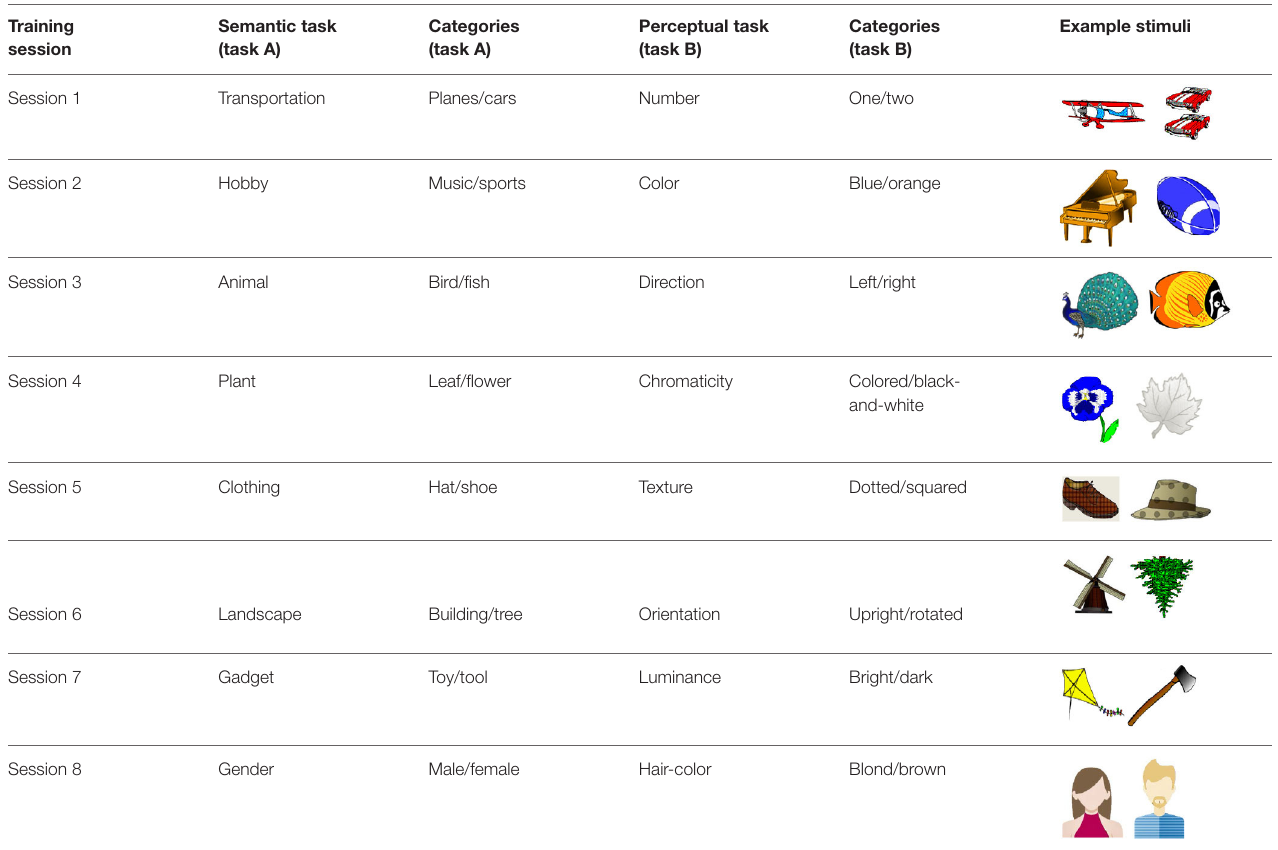
TABLE 2 | Semantic and perceptual tasks used in the eight training